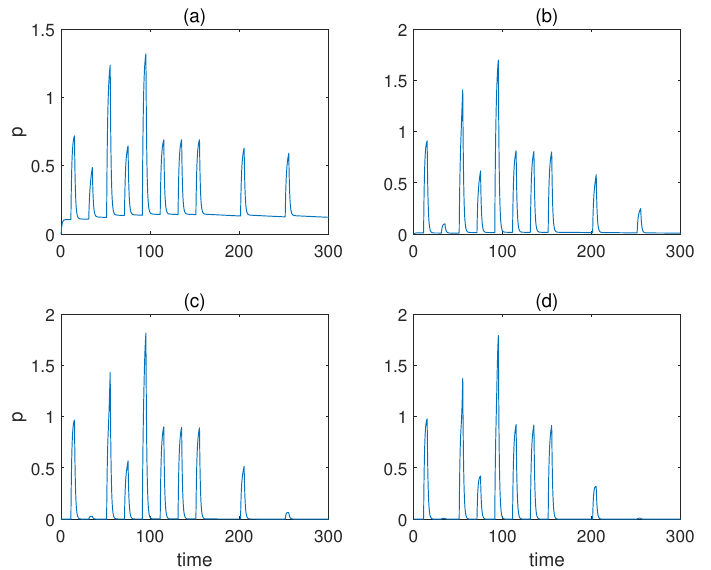
Figure 4. The concentration of molecule p under various Hill coefficients a when the value of b is fixed for Fernando’s model. ( a – d ) Results when a = 1,2,3,4. b = 2, α = 1, β = 0.8, θ = 0.02, τ = 0.1, S = 10, respectively.